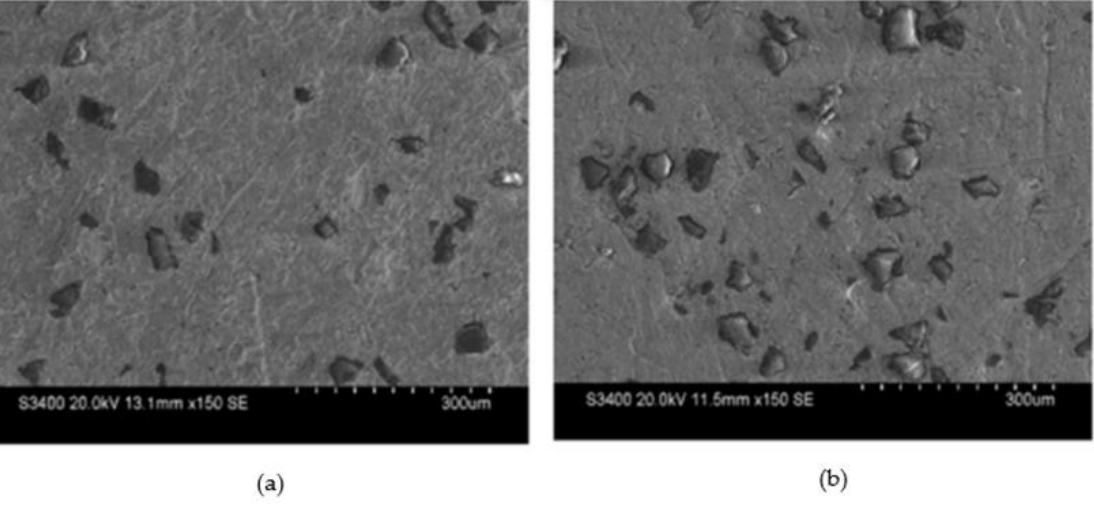
Figure 11. Distribution of abrasive particles on dicing blade surface: ( a ) sparse; ( b ) dense [52].